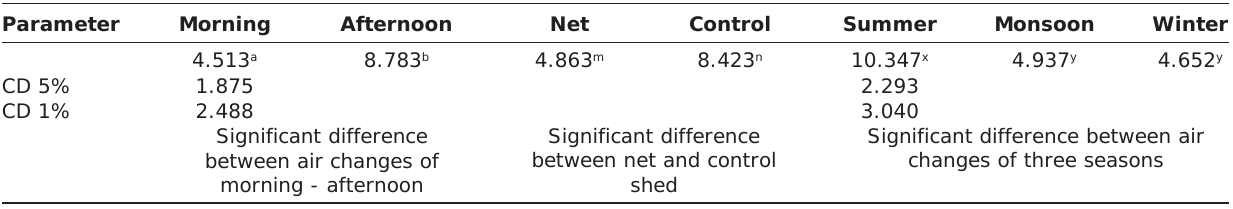
Table-6: Comparison of air changes estimated in the net shed and control shed during the three seasons.